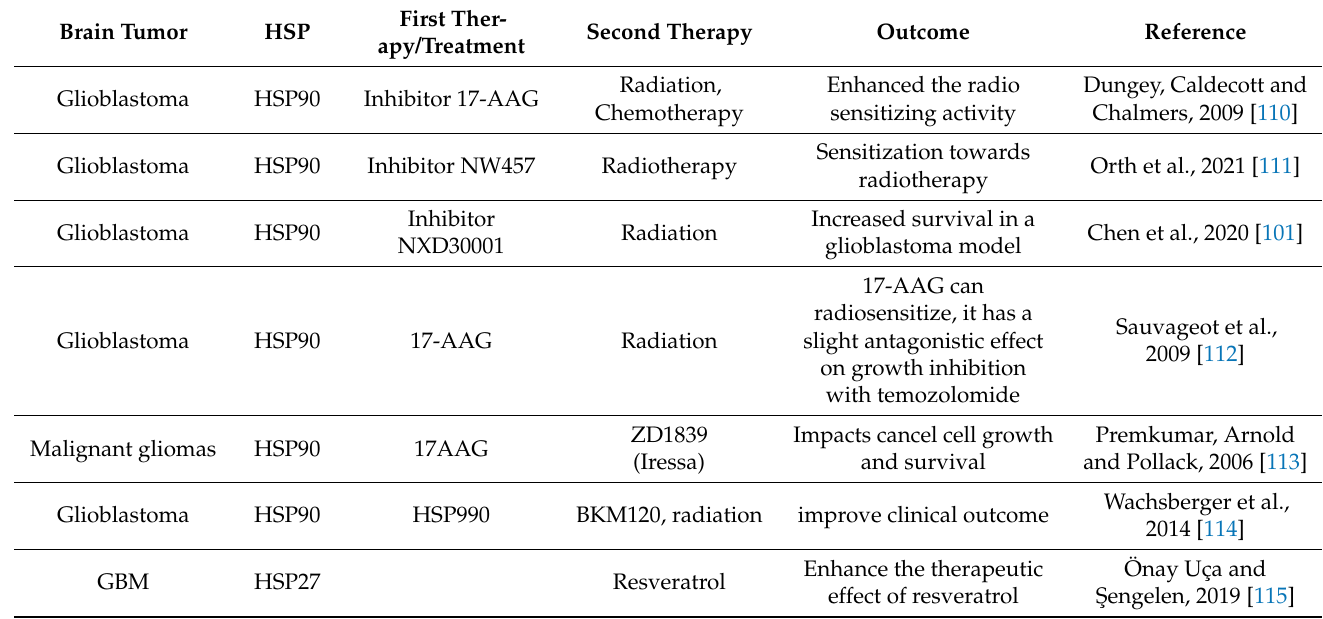
Table 2. A combination of HSPs inhibitors with anti-tumor therapy in malignant brain